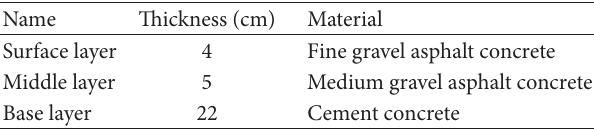
Table 2: Asphalt concrete pavement